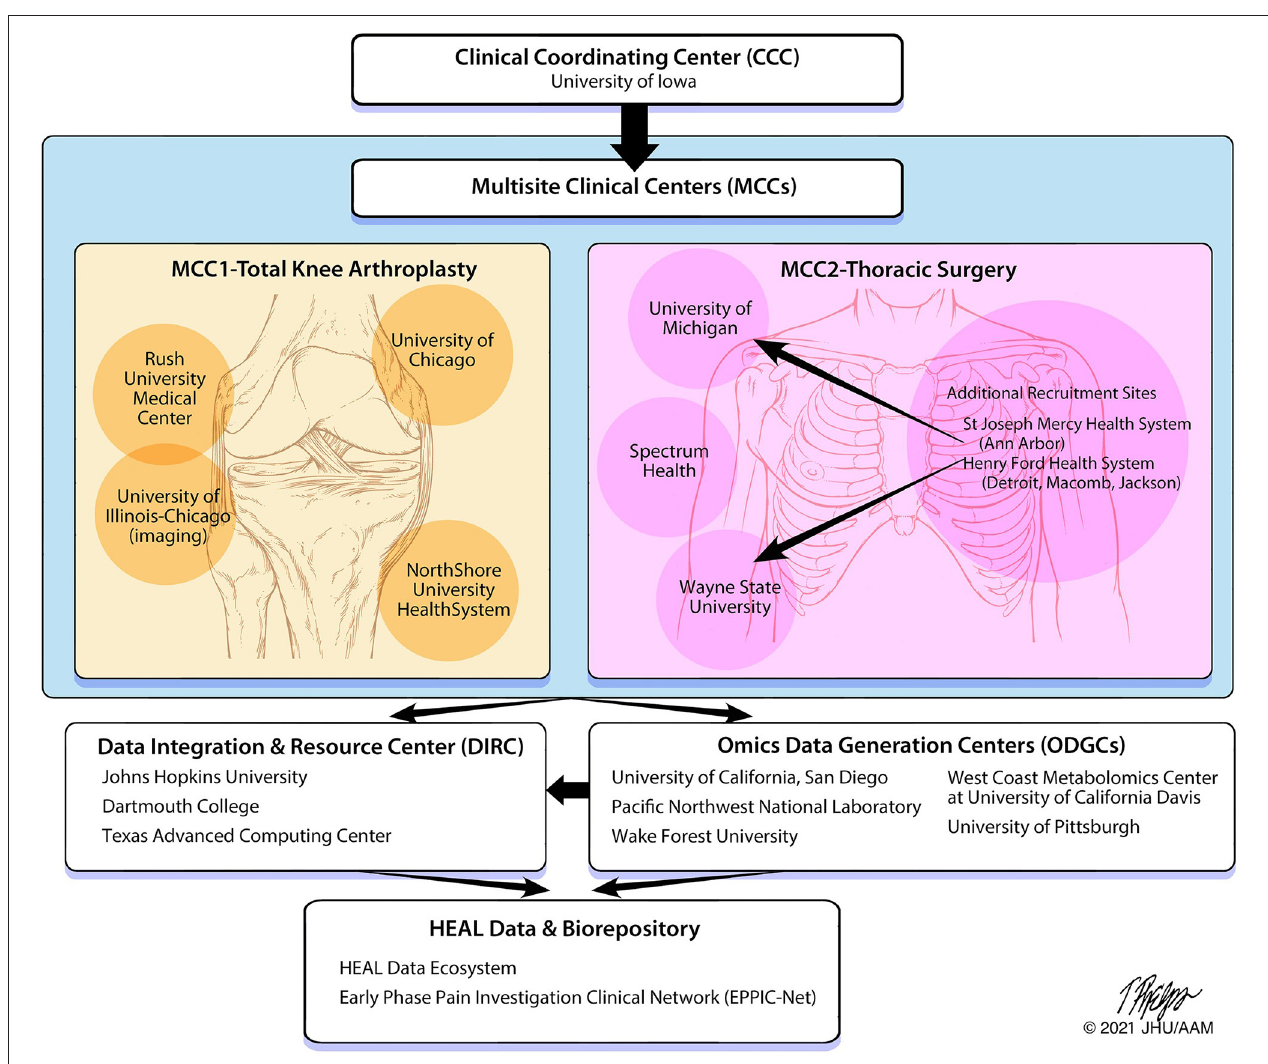
FIGURE 2 | A2CPS structure and data flow. The organization of the A2CPS Consortium includes oversight from the Clinical Coordinating Center, data collection from the Multisite Clinical Centers, data generation from the Omics Data Generation Centers and Data Integration and Resource Center and storing of data and biospecimens within a